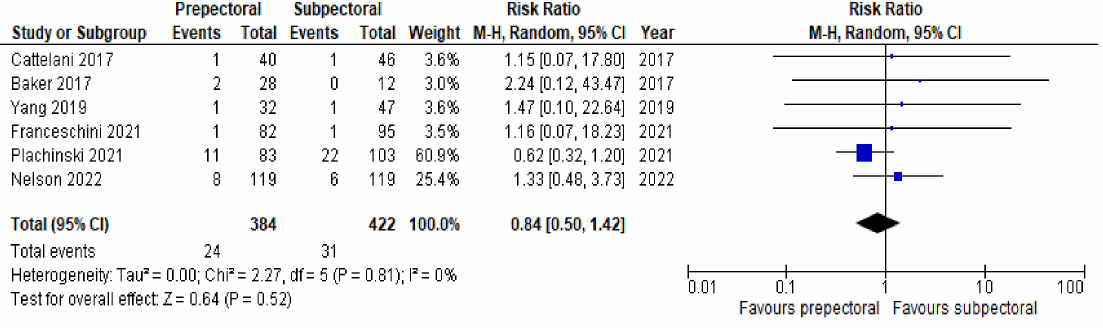
Figure 4. Implant loss